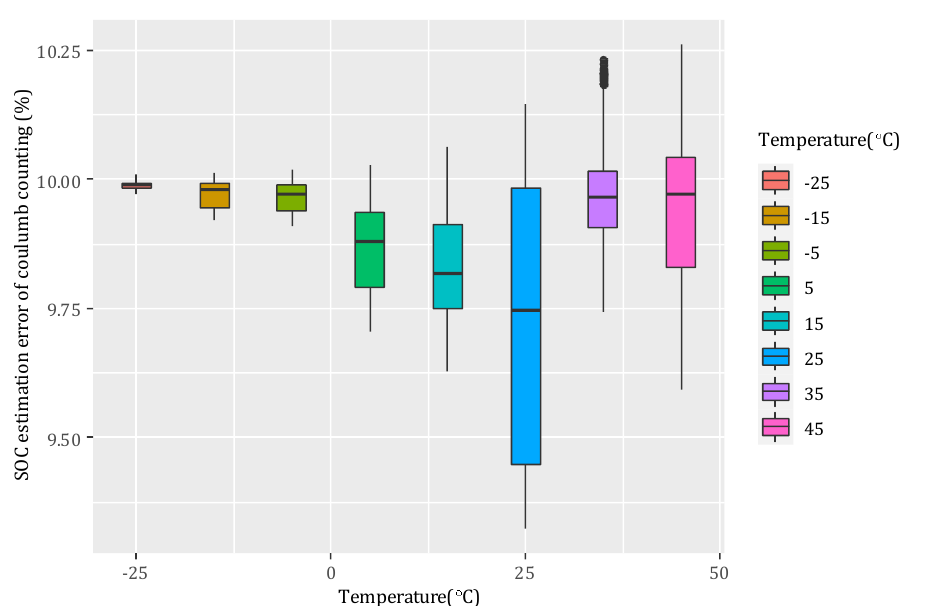
Figure 11. SOC estimation error by CC at various temperatures. The EKF is also implemented for SOC estimation compared with ERTSS. Figure 12 plots the RSE result of EKF and ERTSS at 25 ◦ C. The results at other temperatures are similar to the one at 25 ◦ C. From the zoom part of Figure 12, the RSE of ERTSS is less than the RSE of EKF at the smooth steps. For the estimation at time step k , the ERTSS used the measurements and estimations across the time interval, while the EKF only used the measurement and estimation at time step k − 1. We can improve the RSE results of the ERTSS by increasing the smoothing interval time. However, we should choose the smoothing interval carefully, the minimum SOC refresh rate must be considered according to the applications.